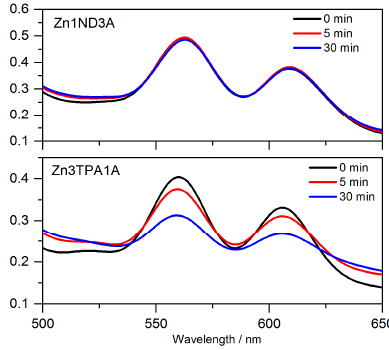
Figure 7. Stability study of Zn 1 ND 3 A and Zn 3 TPA 1 A.